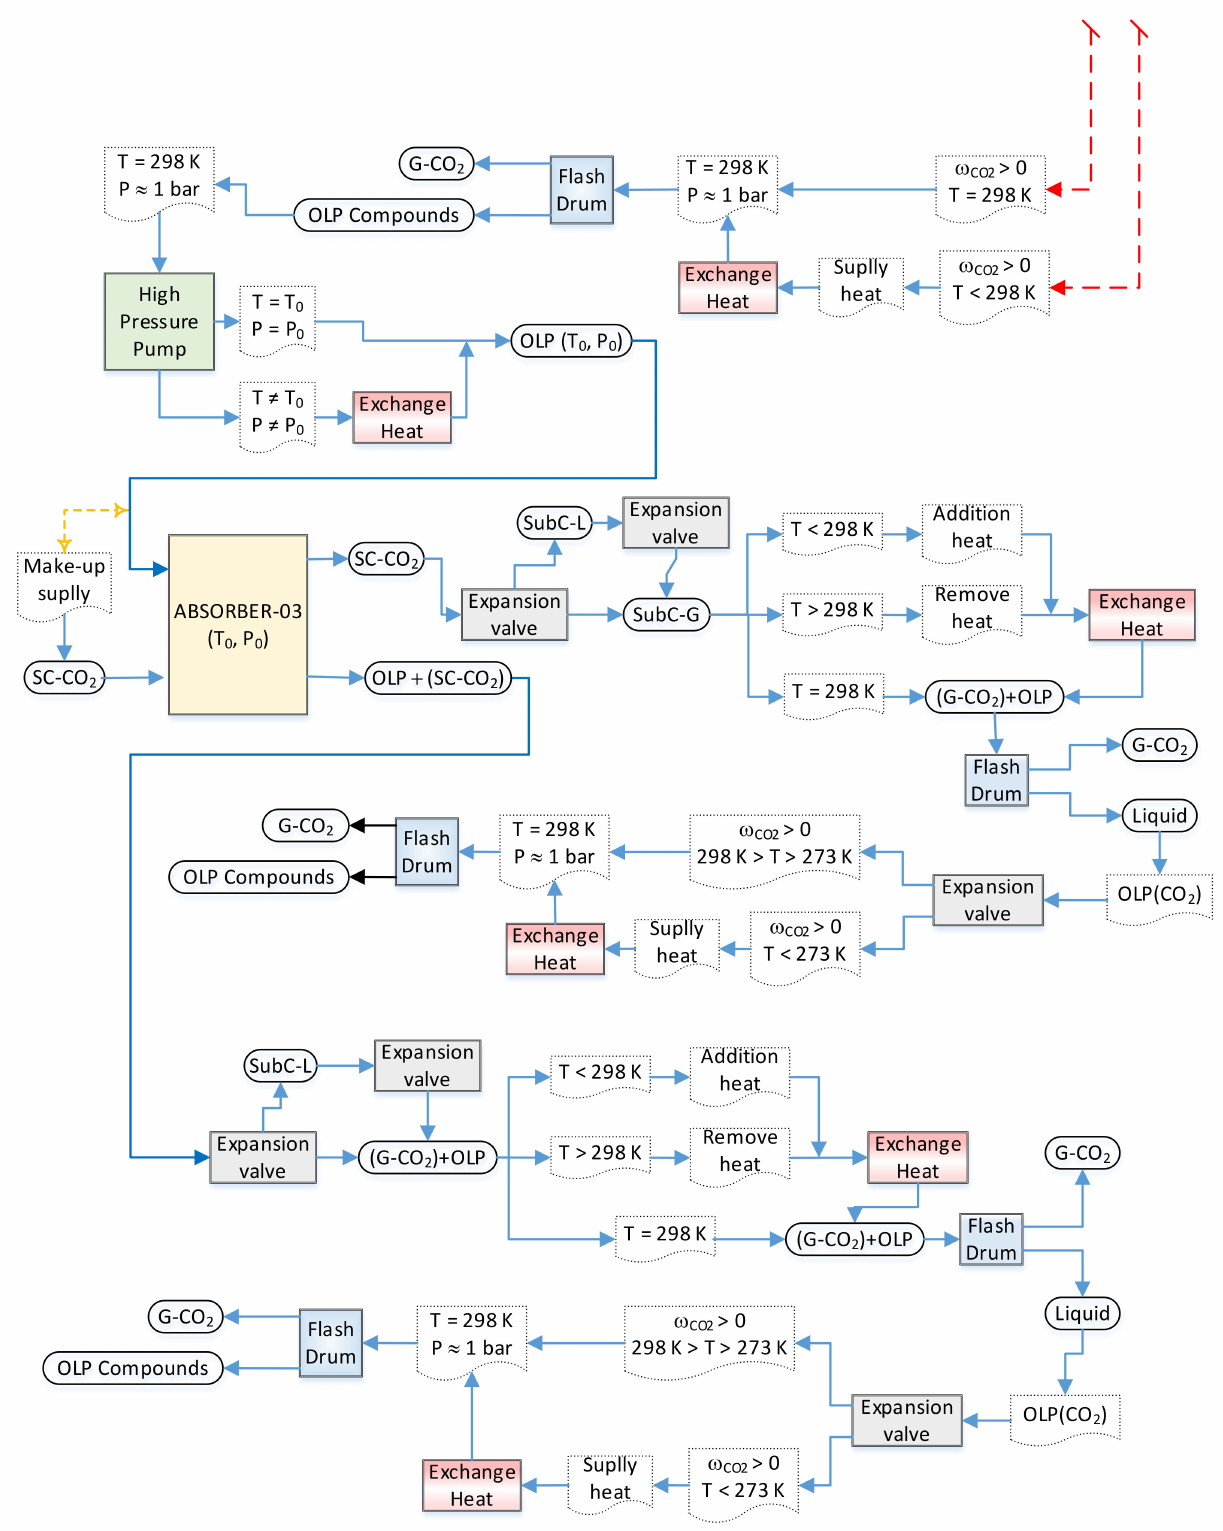
Figure 4. Flowsheet algorithm simulation strategy for the deacidification/deoxygenation of organic liquid products, obtained through the thermal catalytic cracking of palm oil at 450 ◦ C, 1.0 atm, with 10% (wt.) Na 2 CO 3 as a catalyst, in multistage countercurrent absorber columns using SC-CO 2 as a solvent, illustrating sub-flowsheet II with absorber